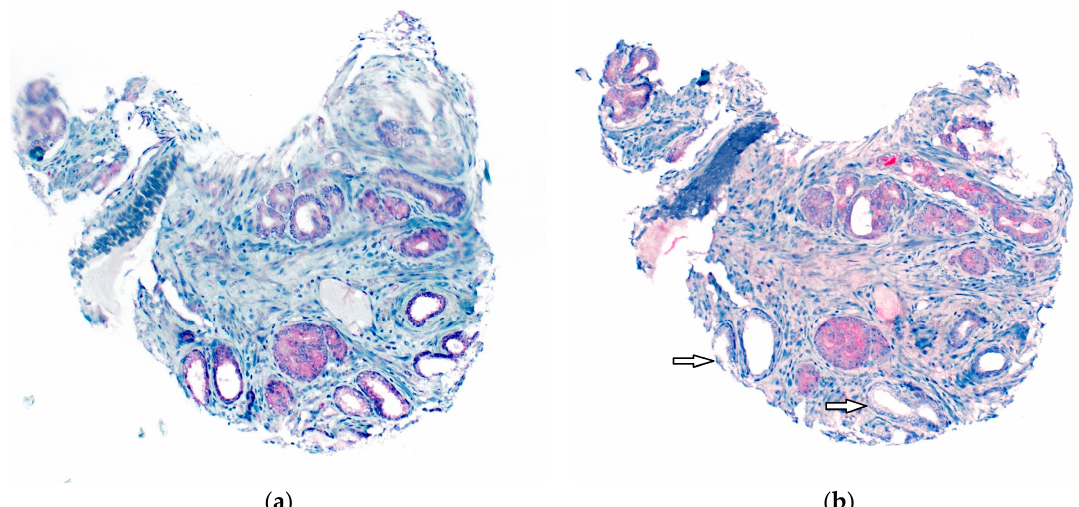
Figure 4. ( a ) Tumor with high FAK expression; ( b ) same tumor is also THSD7A-positive and the adjacent non-tumor tissue is THSD7A-negative (arrows) with a magnification of 100×. Table 3. Association between FAK expression and THSD7A expression